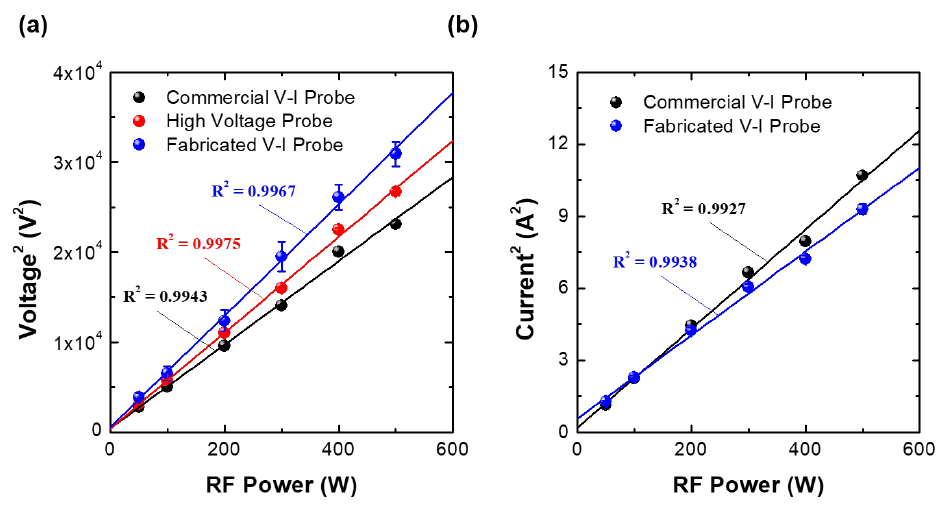
Figure 11. Square of the root-mean-square (RMS) ( a ) voltage and ( b ) current measured by the three probes over RF input power at an argon gas injection rate of 100 sccm, pressure of 20 mTorr, and linearity factors (R-squared values ( R 2